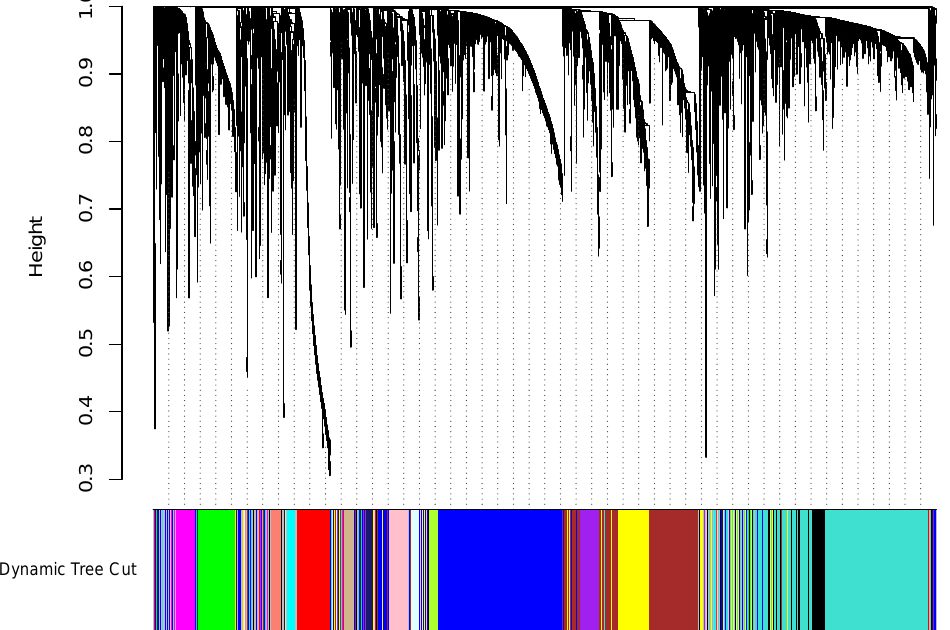
Figure A4. Clustering the DEGs as